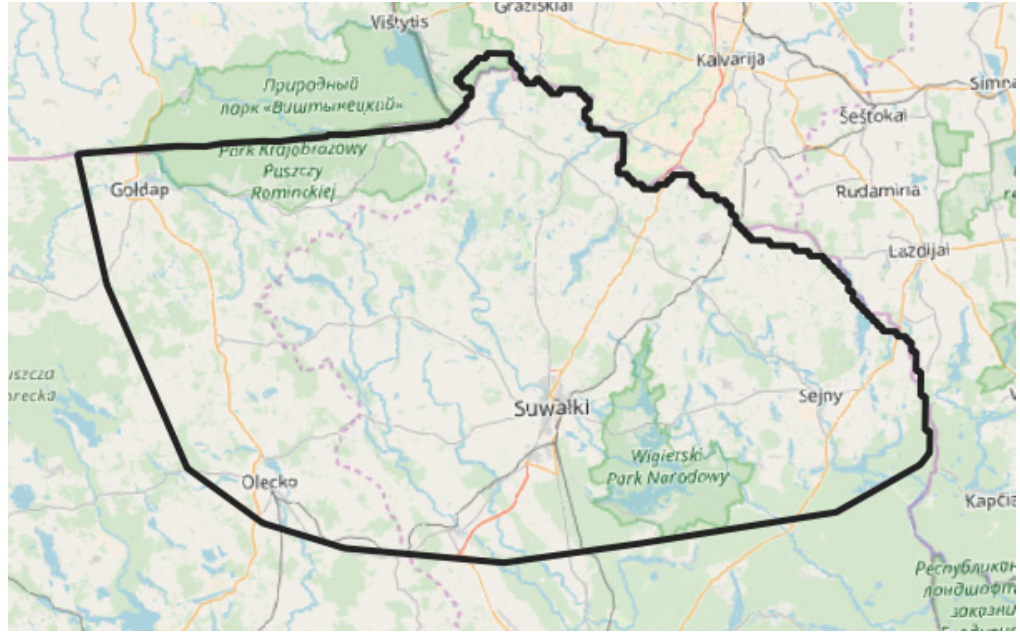
Figure 3. Topographic map of test area, source: © OpenStreetMap contributors .